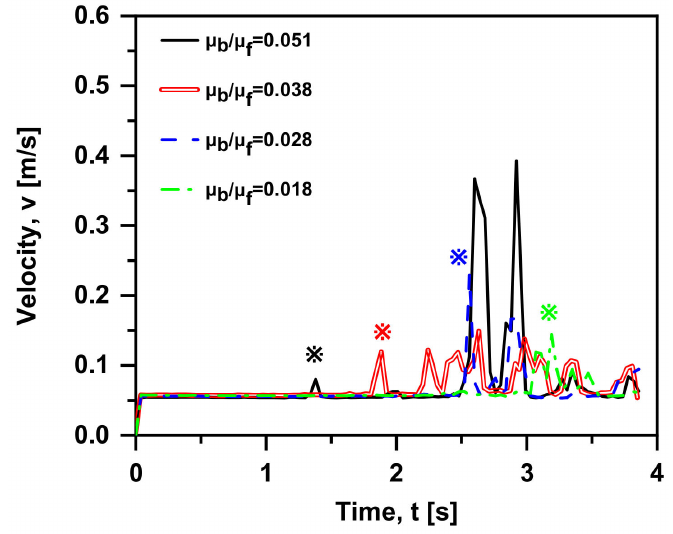
Figure 13. Bubble velocity over time with Basset force at four viscosity ratios ( v 0 = 0 m/s, d b = 1 mm,